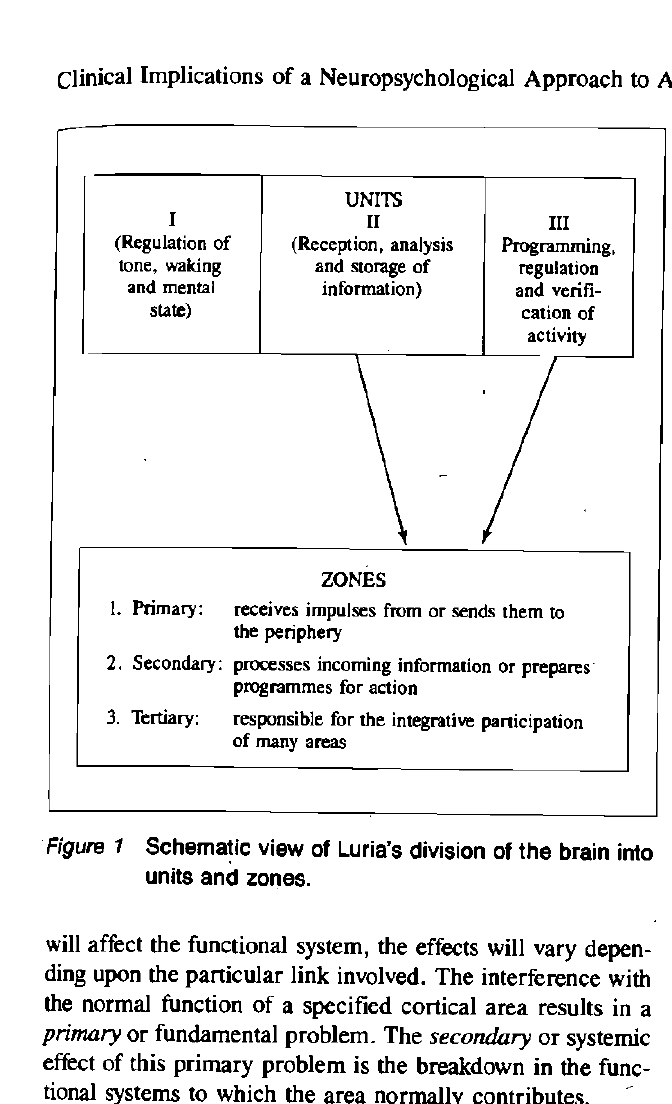
Figure 1 Schematic view of Luria's division of the brain into units and zones.